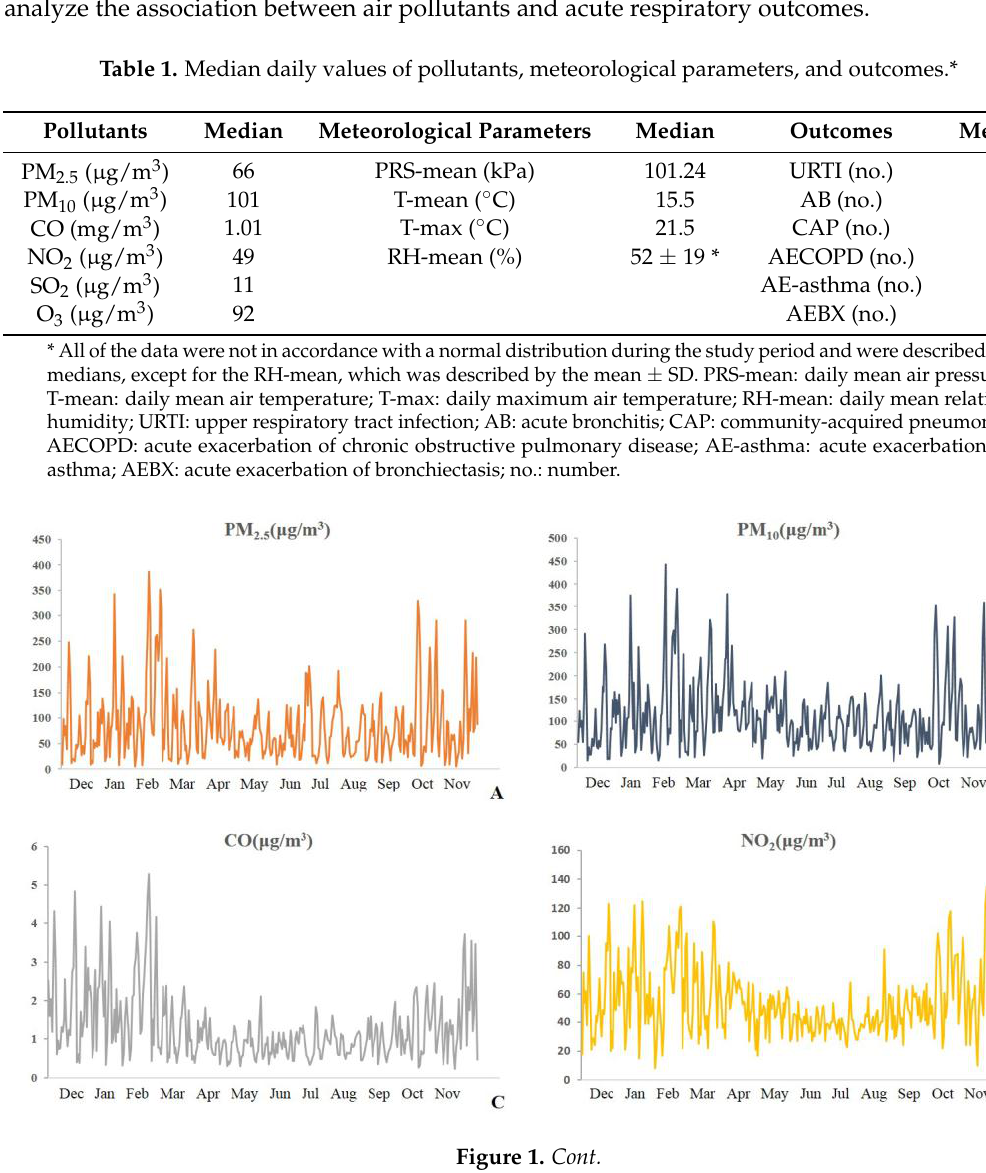
Table 1. Median daily values of pollutants, meteorological parameters, and